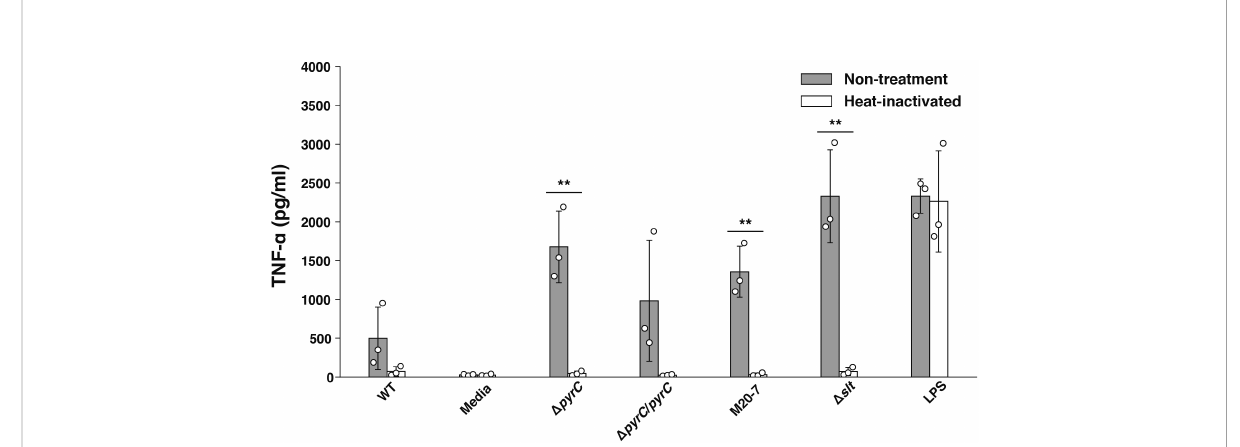
FIGURE 4 TNF- a induction by heat-inactivated F. novicida pyrC deletion mutant. U937 cells were stimulated with 100 ng/ml of E . coli LPS- or same volume BHIc-containing medium or infected with F. novicida strains (MOI = 1). Heat inactivation of the bacterial suspension was performed at 90 ℃ for 5 min. At 5 h post infection, cell supernatants were collected, and TNF- a concentrations were measured by ELISA. Data shows averages and standard deviations from three independent experiments. The differences among various conditions were analyzed by Tukey – Kramer multiple comparison and are indicated by asterisks ** P <